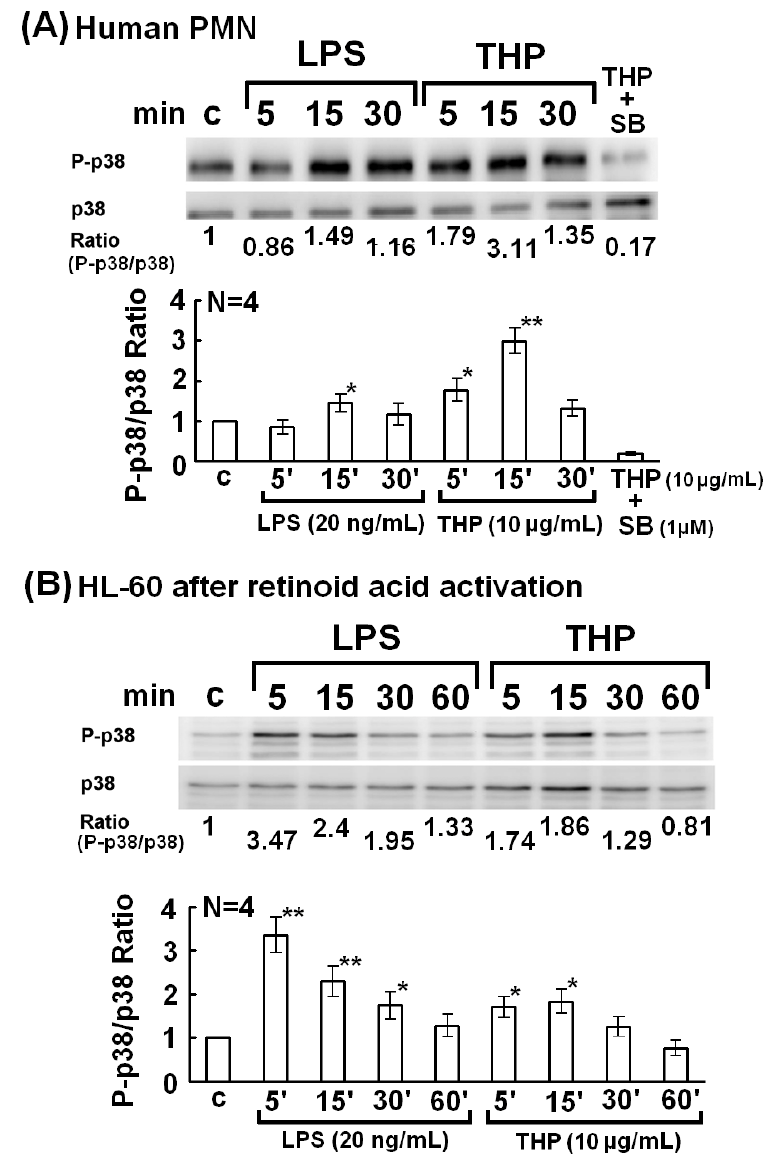
Figure 3. Kinetic expression of p38 MAPK phosphorylation by THP (10 μ g/mL) and LPS (20 ng/mL) stimulation from 5–60 min in normal human PMNs ( A ) and all-trans retinoic acid (2 μ M)-activated human promyelocytic leukemia HL-60 cells ( B ). The upper panel shows a representative case and the lower panel shows the statistical assessment in both ( A ) and ( B ). * denotes p ≤ 0.05 and ** denotes p ≤ 0.01 compared to